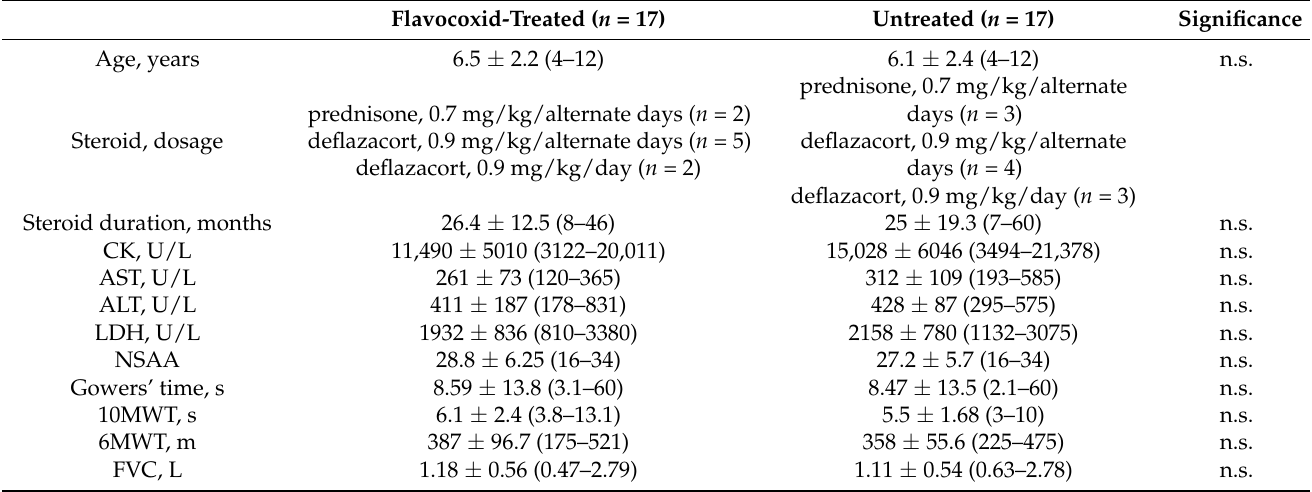
Table 1. Baseline characteristics of the Duchenne muscular dystrophy (DMD) patients, expressed as mean ± SD (range). Flavocoxid-Treated ( n =